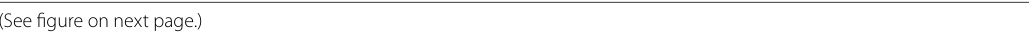
Fig. 4 Schematic representation of BPH-Rice interaction. Using its stylet, the insect pierces the rice tissue and reaches the phloem to suck the sap. During this process, both gelling and watery saliva are secreted by the insect, which contain various molecules that elicit or act against plant defense. Proteins like catalase, endoglucanase, and Ca 2 + -binding proteins might be involved in suppressing the plant defense while proteins like Mucin-like proteins, Apolipophorins, and Protein disulfide isomerase elicit immune responses. Some of these proteins were found to induce callose deposition, cell death and SA or JA- associated defense gene